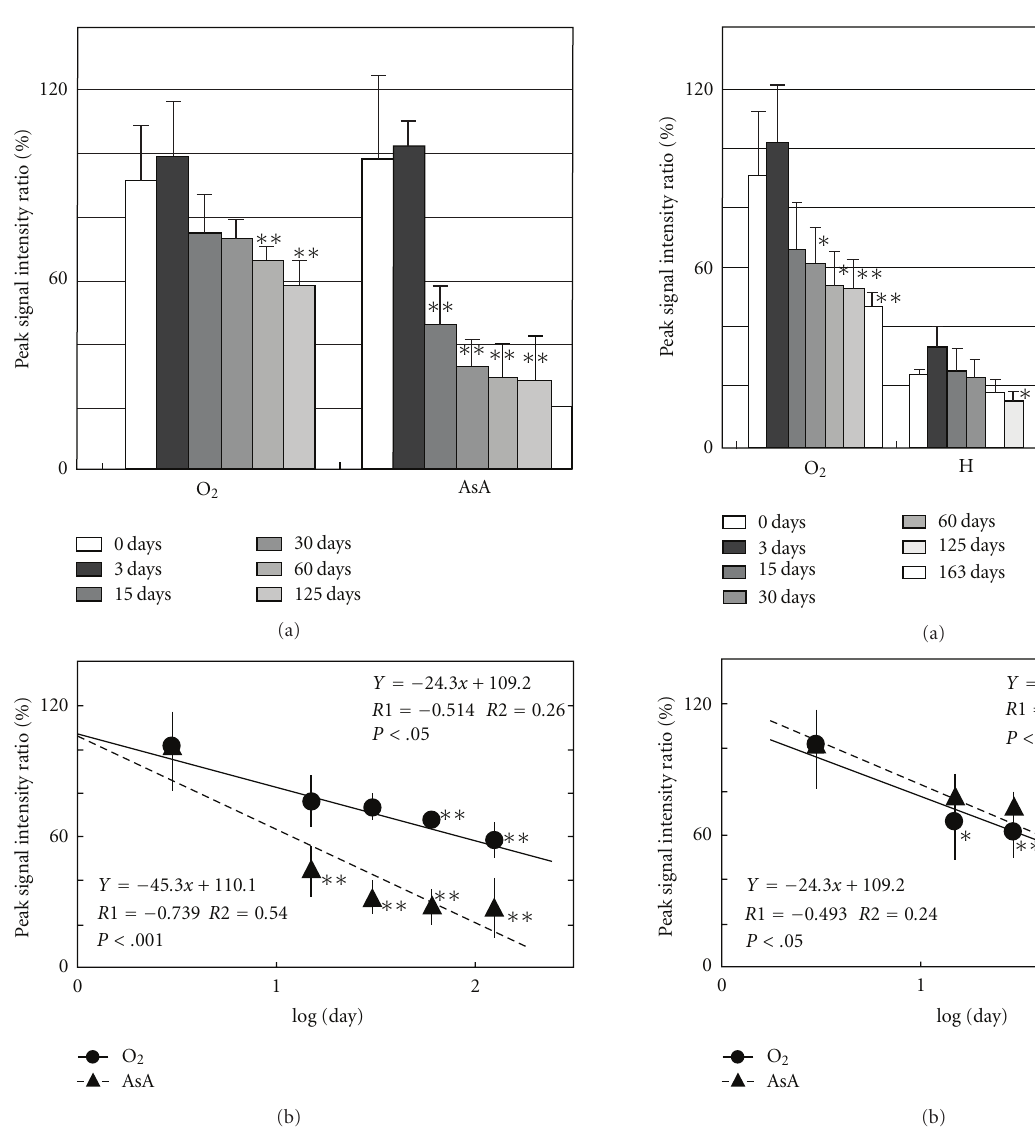
Figure 4: (a) Postmortem DMPO-adduct signal intensity in mouse lung. The columns and the lines show the postmortem signal intensity ratios of brain and S.E.M. of the means ( n = 8). The y - axis shows the percentage of peak signal intensity ratio, which was calculated by assuming that the intensity of MnO (500nmol/L) was 100%. ∗ P < . 05, ∗∗ P < . 01, versus 0 days. (b) Time course of postmortem DMPO-adduct signal intensity ratio in mouse lung. The y -axis shows the percentage of peak signal intensity, which was calculated by assuming that the intensity at 3 day postmortem was 100%. X -axis is expressed in log(day). ∗ P < . 05, ∗∗ P < . 01, versus 3 days. The regression lines, correlation coe ffi cient ( R1 ), contribution rate ( R2 ), and the probability of error ( P -value) were